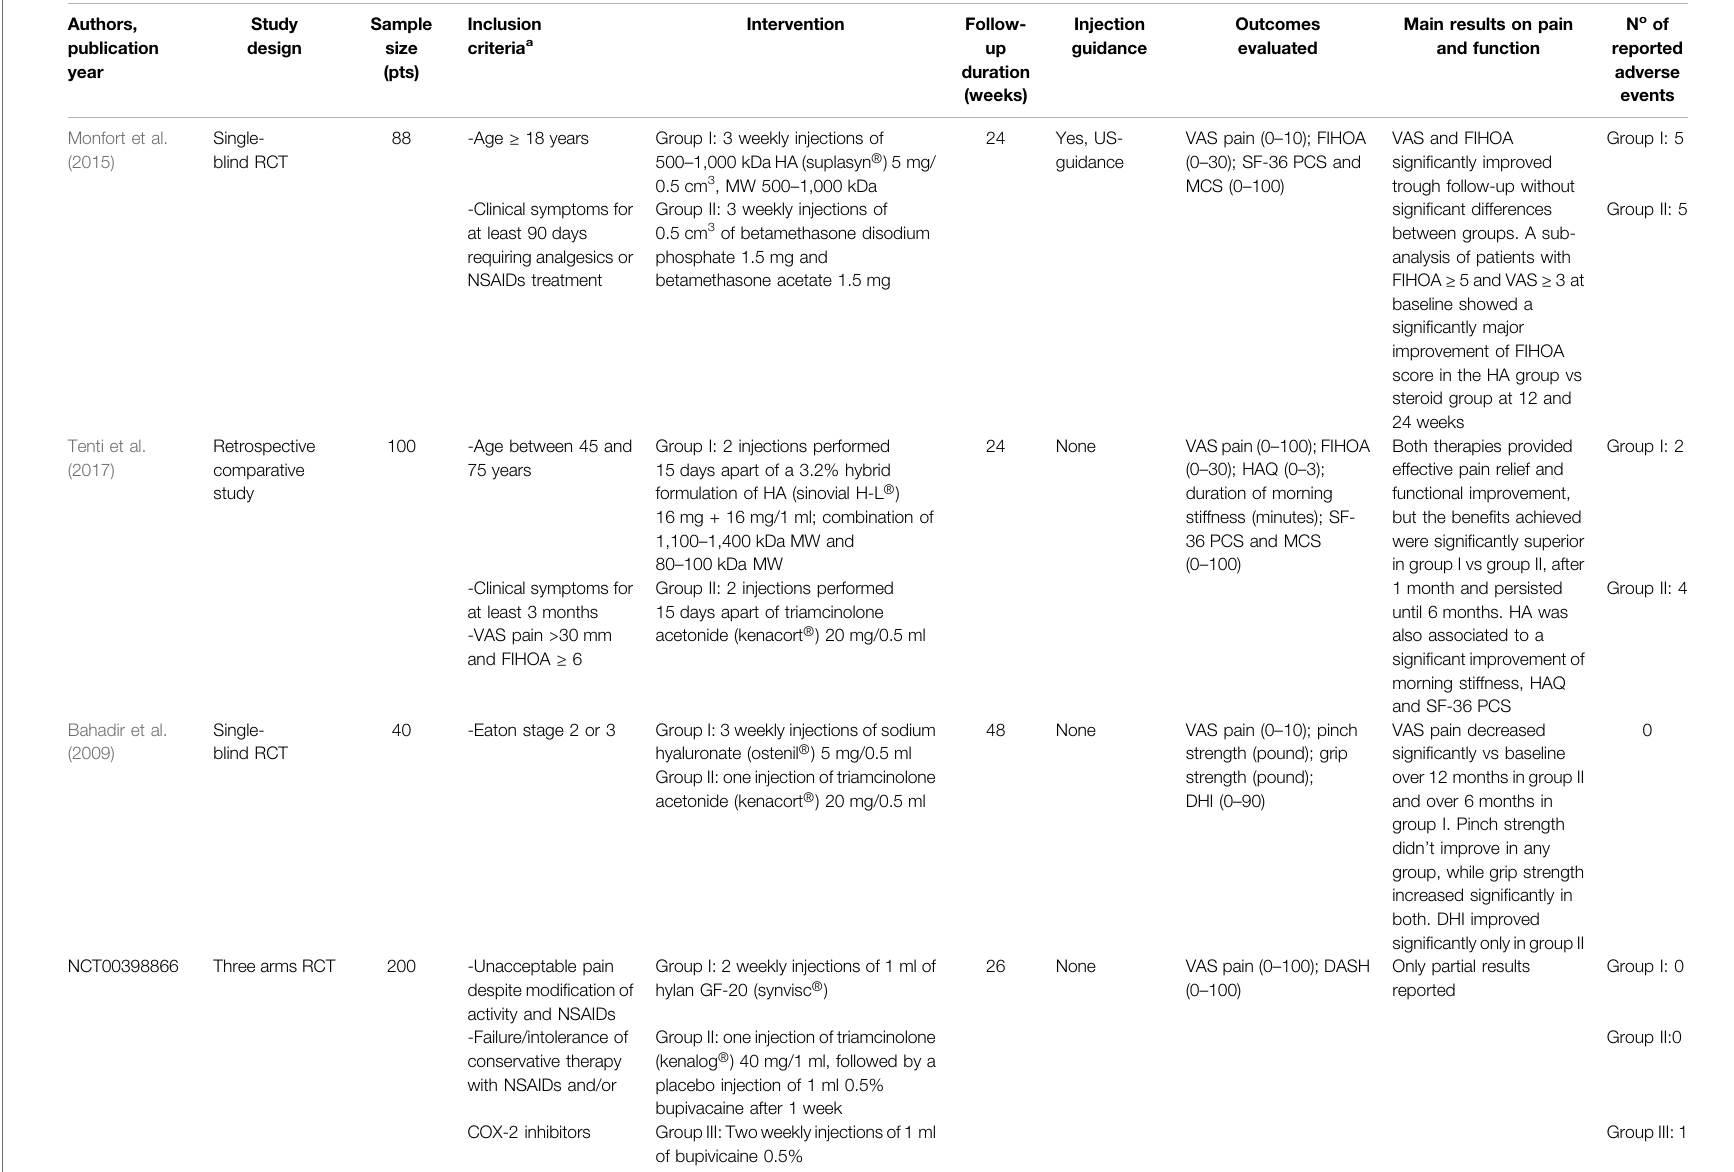
TABLE 2 | ( Continued ) Summary of studies investigating intra-articular injections of hyaluronic acid for the treatment of thumb-base